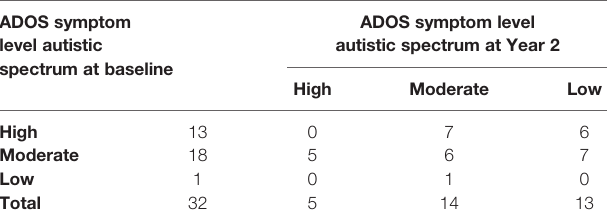
TABLE 4 | Changes of ADOS symptom levels from baseline to Year